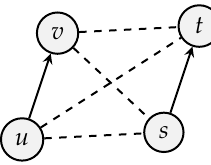
v and s t cannot be scheduled on the same channel/code ↔ ↔